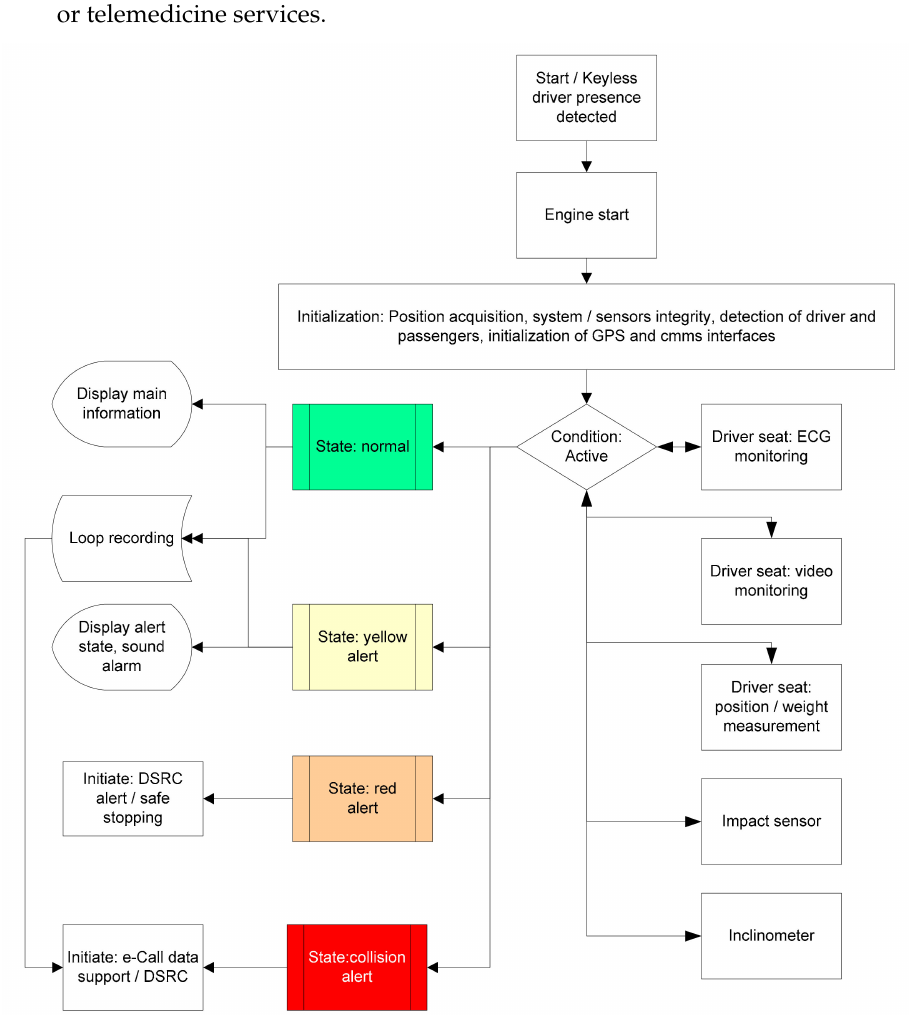
Figure 9. Algorithm for cooperative driving information exchange with enhanced e-Call/ telemedicine